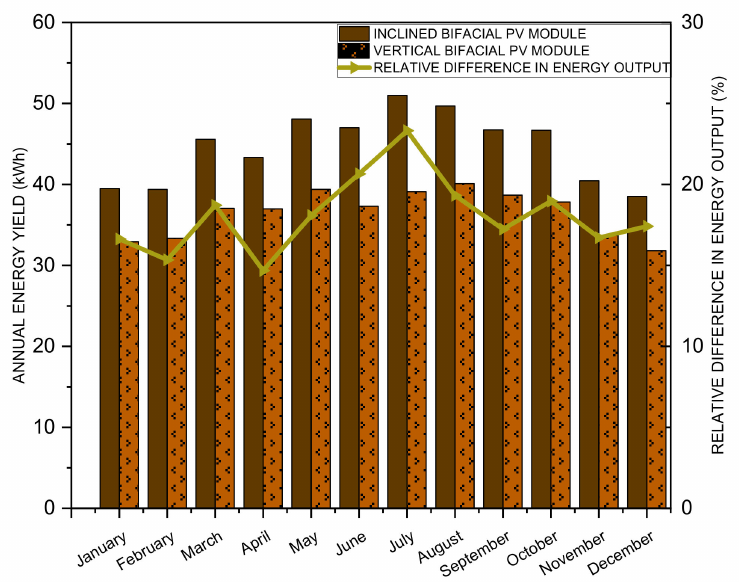
Figure 6. Modelled annual potential energy yield for inclined and vertical bifacial stand-alone PV